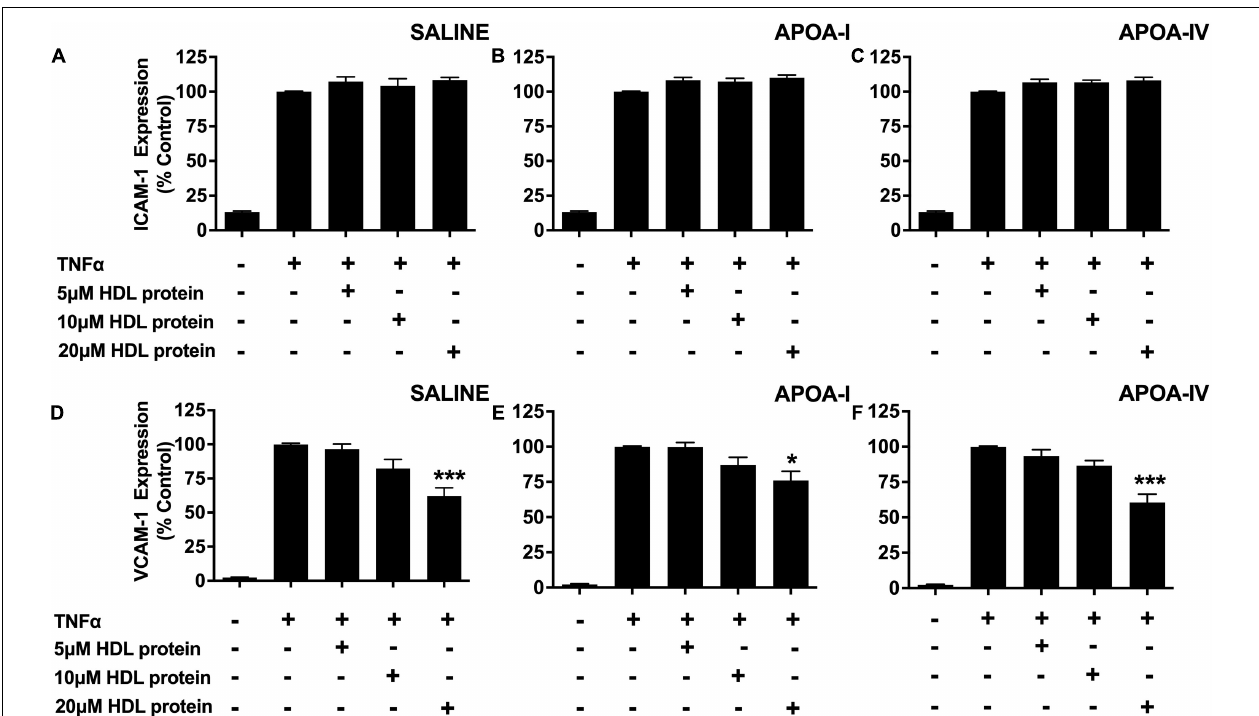
FIGURE 2 | A single apoA-IV infusion does not alter the anti-inflammatory properties of rabbit HDLs. HDLs were ultracentrifugally isolated from NZW rabbits that had been treated with saline [Panels (A,D) ], lipid-free apoA-I [Panels (B,E) ] or lipid-free apoA-IV [Panels (C,F) ] as described in the legend to Figure 1 . The isolated HDLs (final apoA-I concentration: 5, 10, or 20 µ M) were incubated at 37 ◦ C for 16 h with HCAECs prior to stimulation with TNF- α (0.2 ng) for 5 h at 37 ◦ C. ICAM-1 and VCAM-1 protein expression was quantified by flow cytometry. Data points represent mean ± SEM of three independent experiments with three replicates/experiment. * p < 0.05, *** p <